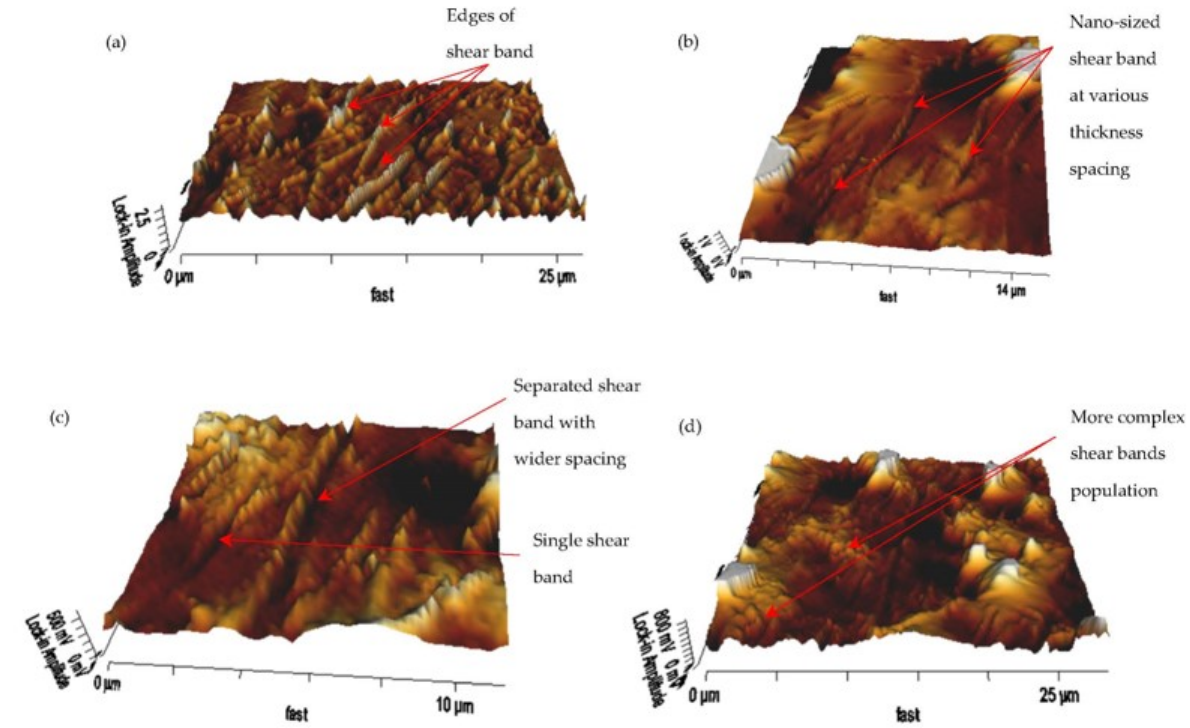
Figure 8. Three-dimensional AFM amplitude micrograph of the shear band deformation in the MRE matrix ( a ) edges detection, ( b ) nearly parallel shear band, ( c ) wider spacing of domain separation, and ( d ) complex shear band